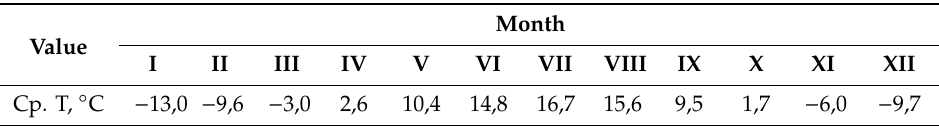
Table 1. The average monthly values of air temperature according to observations at a meteorological station in